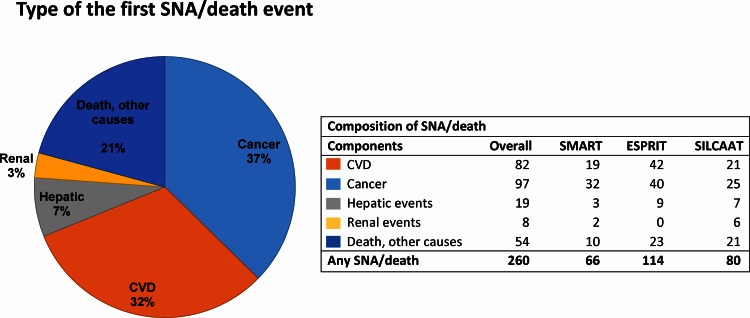
Composition of the serious non-AIDS disease or death (SNA/death) endpoint.Only the first event per participant is counted.